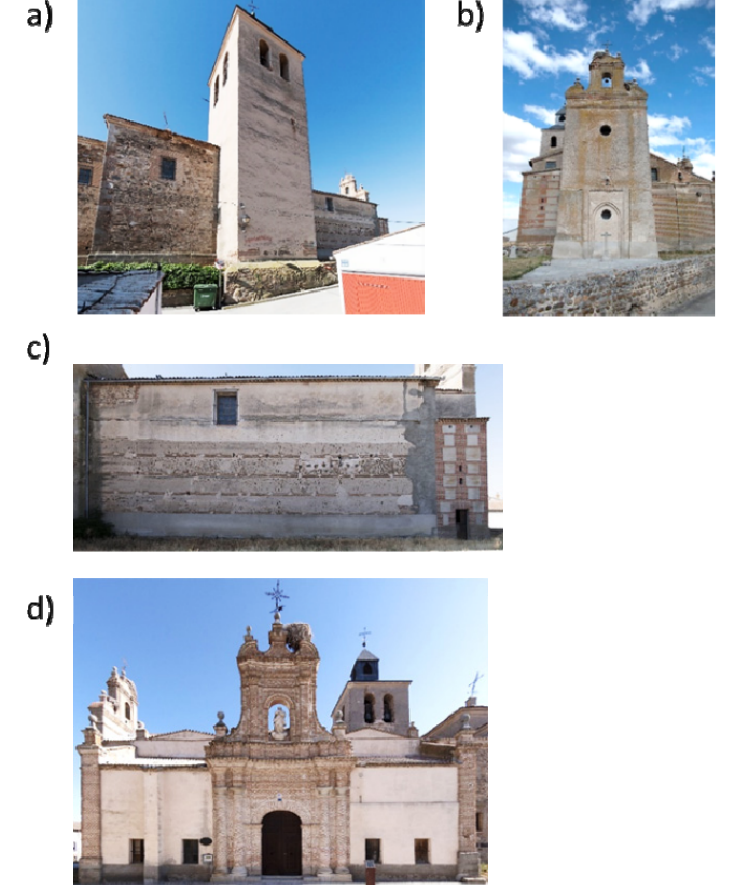
Figure 3. External views: ( a ) general view of the tower that is placed at the crossing of the church; ( b ) general view of the tower placed at the baptistery; ( c ) the main façade; and ( d ) opposite façade. Regarding its conservation status, the temple shows water infiltration problems due to the lack of maintenance of the roof. These infiltrations favour the presence of biological attacks, as well as important deformations in a great part of the rafters that are used to cover the secondary naves. Additionally, it is possible to observe out-of-plane move- ments in the vertical walls of these naves. All these damages demand an accurate 3D